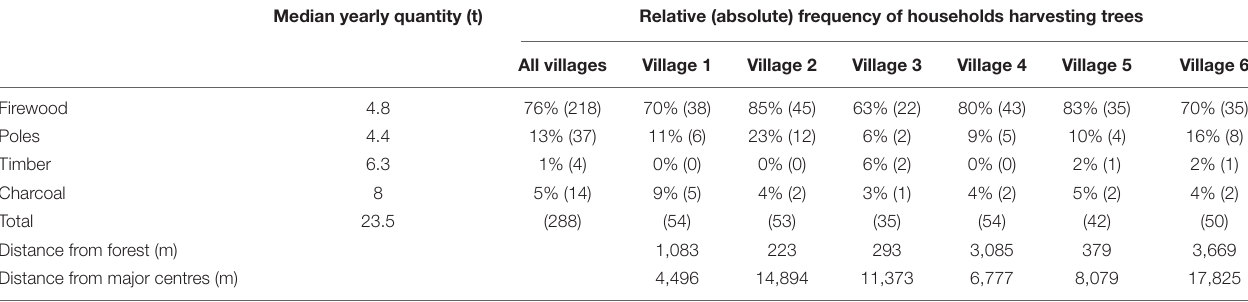
Number in parentheses is the absolute number of respondents in each category.